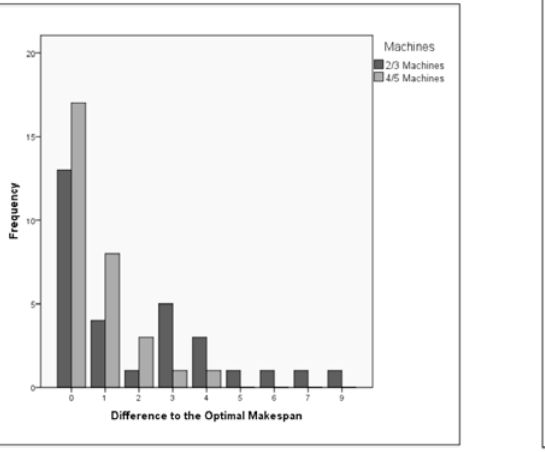
Fig. 8. Bar chart of the solutions for 2/3 and 4/5 machines